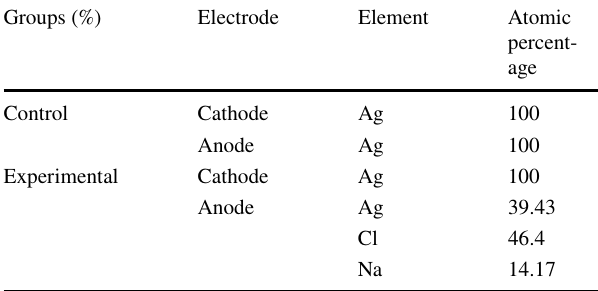
Table 1 EDS element analysis of the cathode and anode in the con- trol and experimental groups after exposure to O 2 for 5 h Groups